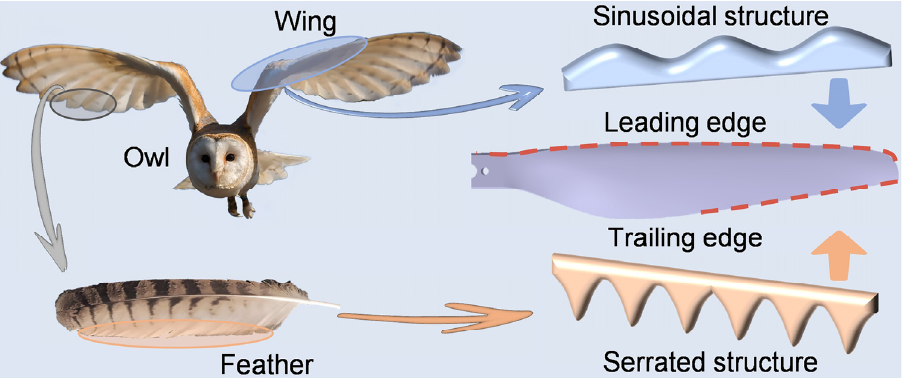
Figure 3. Bionic edge design strategy for leading and trailing edges of the OR with inspiration from owl wings and feathers. Source of the owl image: https://pixy.org/4654605 (accessed on 20 March 2022), reproduced with permission.